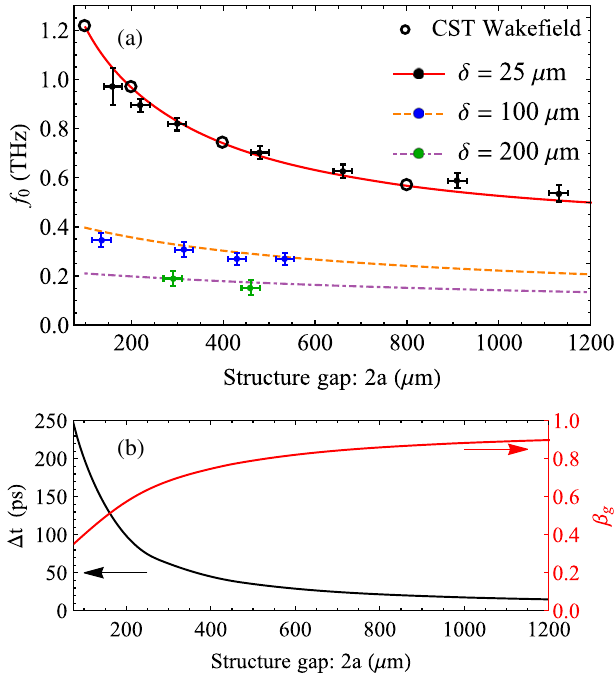
FIG. 4. (a) Measured frequency of the fundamental mode as a function of the structure gap at three dielectric thicknesses of 25, 100, and 200 μ m. Vertical error bars represent FWHM width of spectral lines. Solid lines are solutions of the dispersion relation in Eq. (1). (b) Calculated CCR group velocity, relative to the speed of light in vacuum, and corresponding CCR pulse length [Eq. (3)] as a function of the structure gap for the case of 25 μ m thick